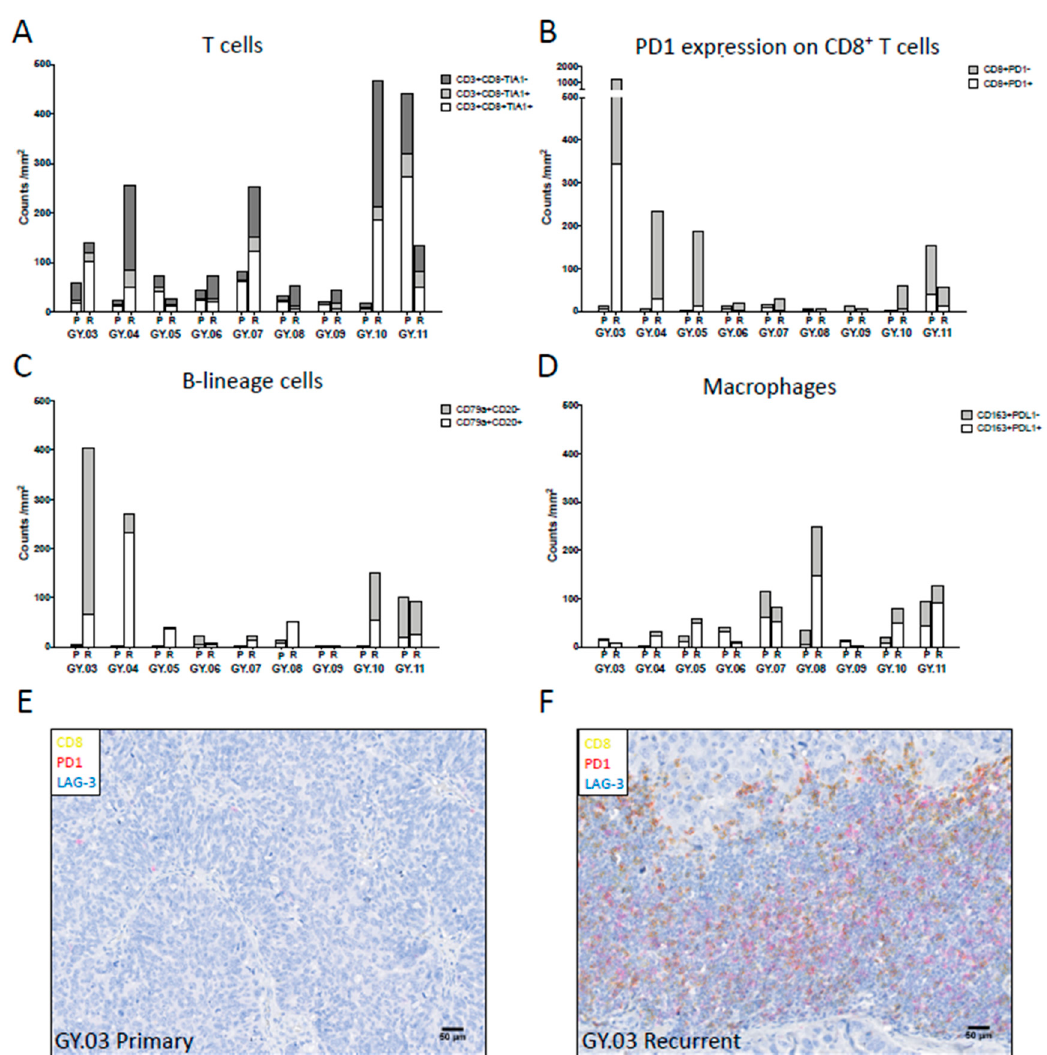
Figure 1. The Immune infiltration in the tumor microenvironment (TME) of the primary (P) and recurrent (R) ovarian tumor samples was analyzed using multicolor IHC analysis. ( A ) T cell panel illustrating cytotoxic CD8+ T cells (CD3+CD8+TIA1+) in white, cytotoxic CD4+ T cells (CD3+CD8-TIA1+) in light grey and helper CD4+ T cells (CD3+CD8-TIA1 − ) in dark grey. ( B ) Exhaustion panel illustrating exhausted/antigen-specific CD8+ T cells (CD8+PD1+) in white and PD-1 negative CD8+ T cells (CD8+PD1 − ) in light grey. ( C ) B cell panel illustrating B cells (CD79a+CD20+) in white and plasma